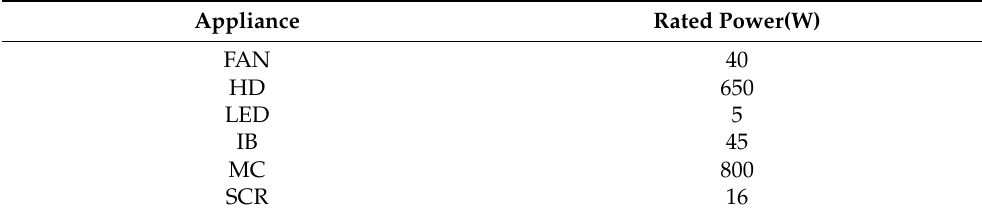
Table 1. The detailed experimental appliance parameters.